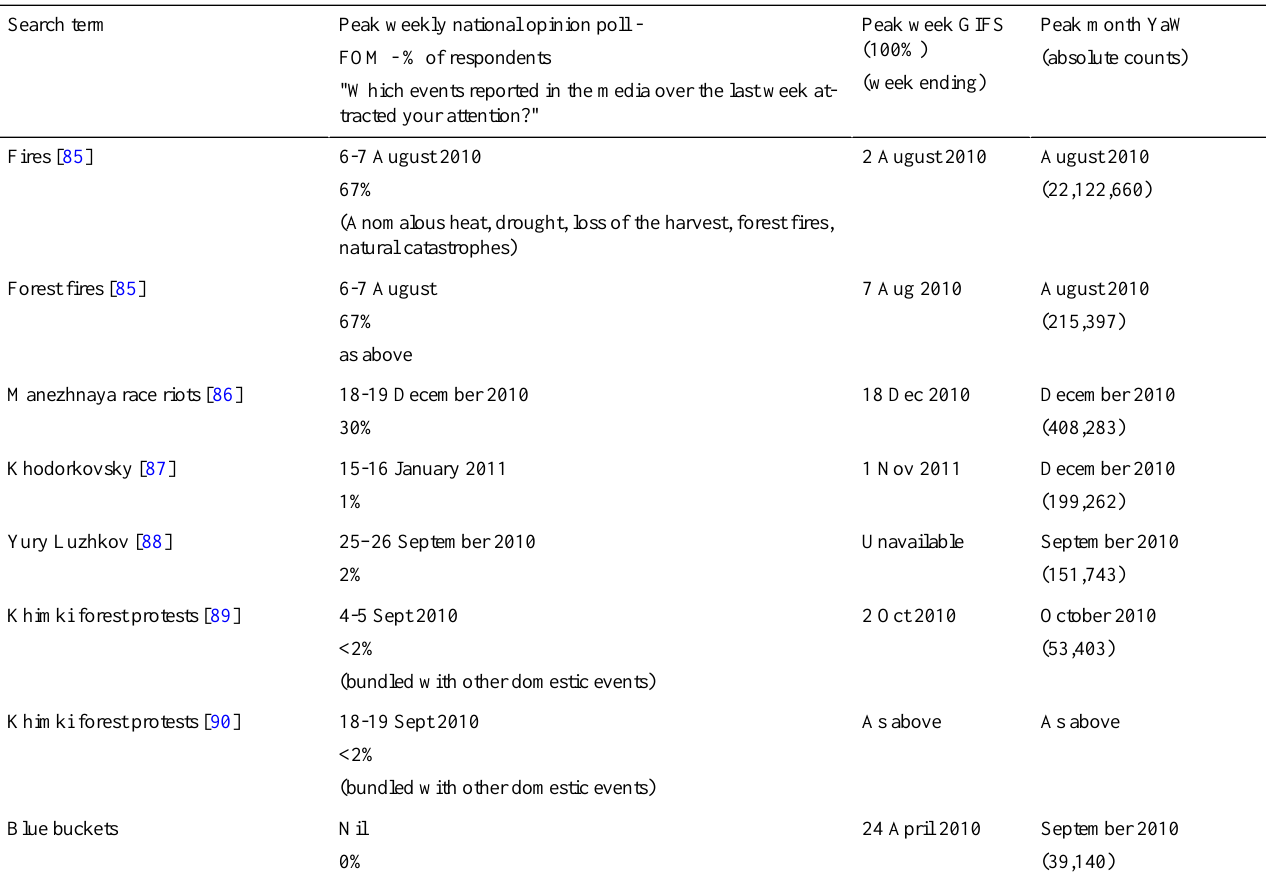
Table 5. Peak interest in Russian domestic events concurrent with the Bychkov episode based on Public Opinion Foundation (FOM) GIFS and YaW during